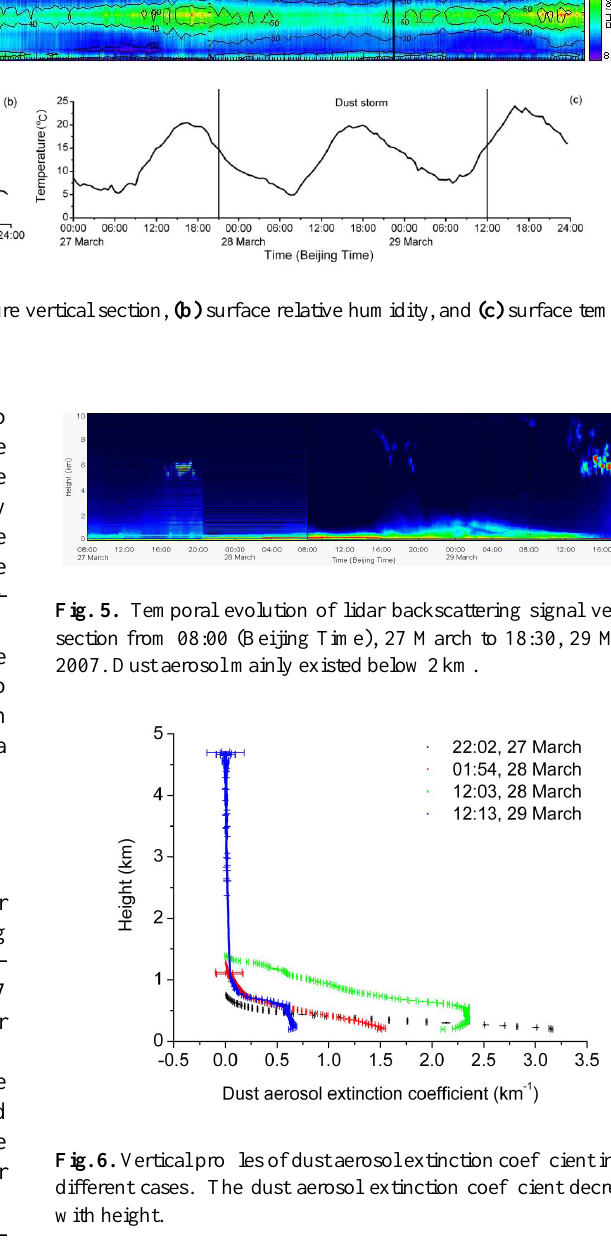
The dust aerosol extinction coefficient decreased with height.